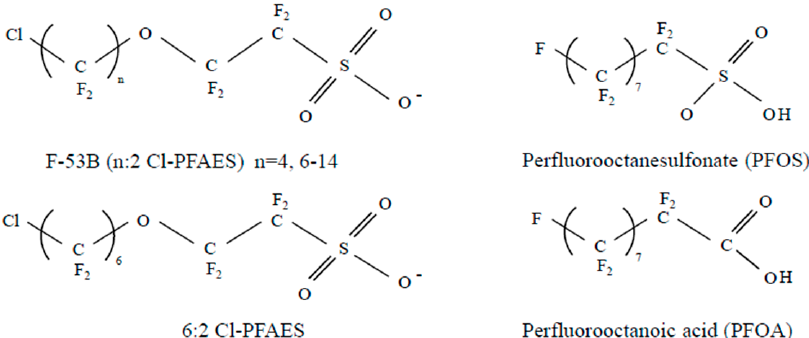
Figure 1. Molecular structural differences between C8-PFASs. All chemicals have eight carbons. Differences between 6:2 Cl-PFAES and PFOS are ether residue. PFOS and 6:2 Cl-PFAES contain in sulfonate and PFOA includes carboxylic acid residue.